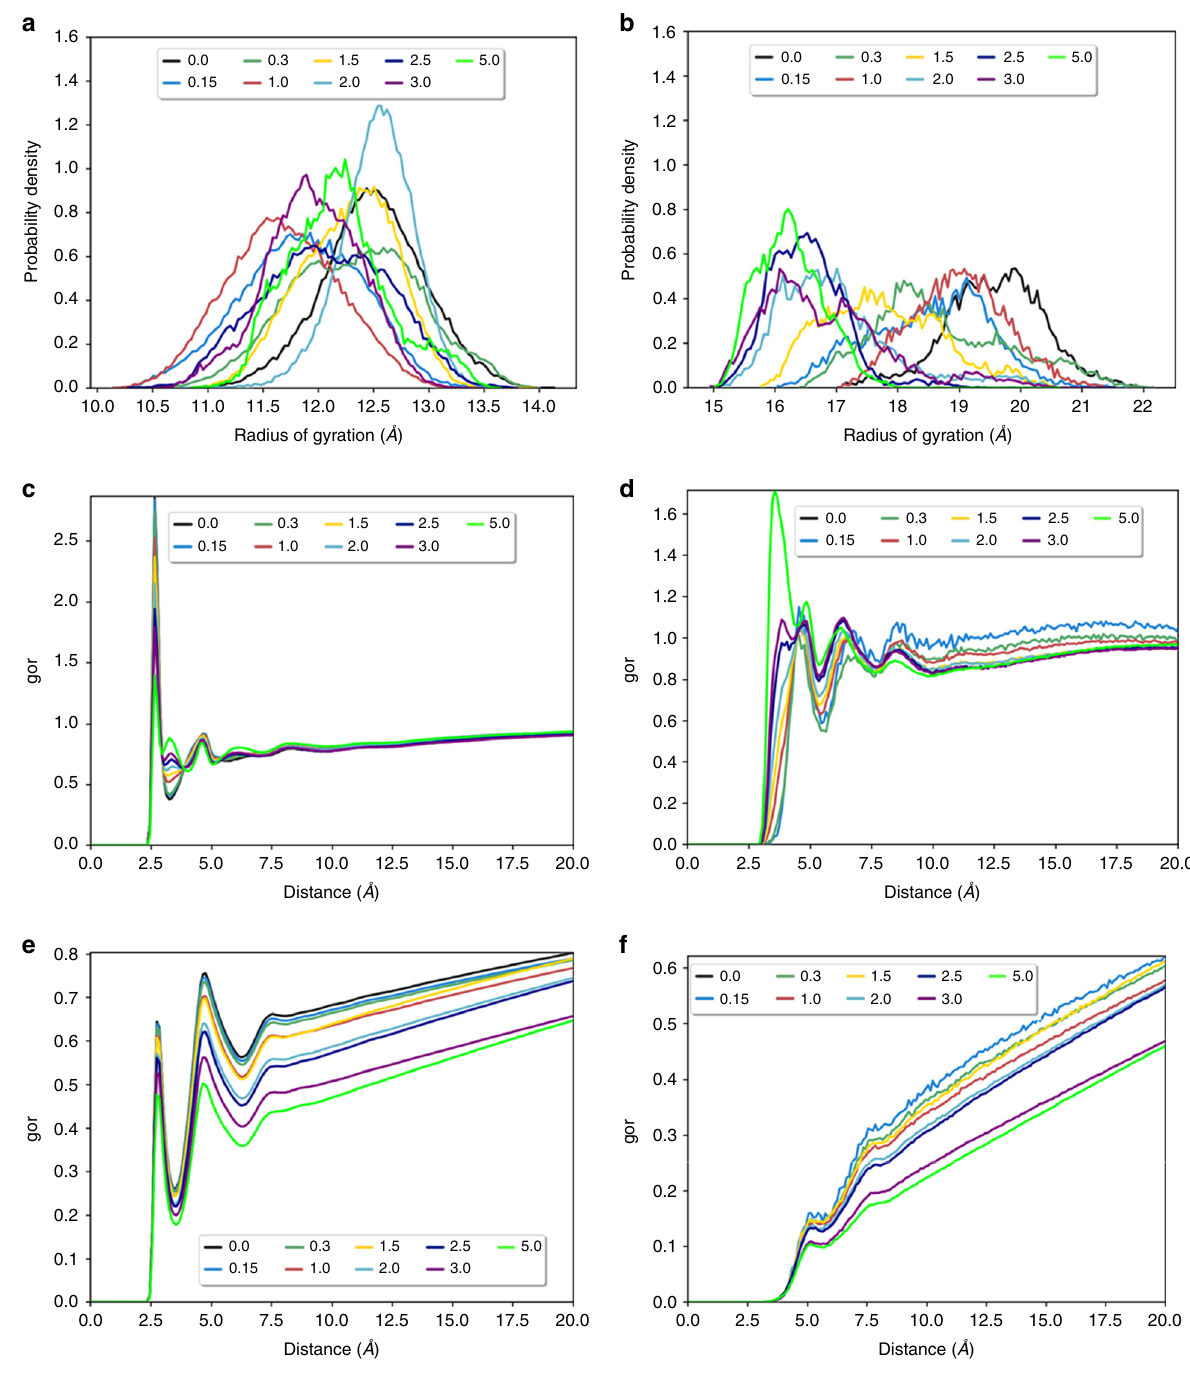
Fig. 4 Conjugate size and hydration state from MD simulations. Radius of gyration of a free pCBMA and b free pOEGMA in increasing NaCl concentration. Radial distribution functions (RDF) for Lyz(5 + )pCBMA DP 18 between c water molecules and O − atoms of pCBMA and d Cl − ions and O − atoms of pCBMA in increasing NaCl concentrations. Hydration layer increases as NaCl concentration increases and both water molecules and Cl − ions become more ordered. Radial distribution function analyses for Lyz(5 + )pOEGMA DP 25 between e water molecules and PEG in the pOEGMA monomer side-chain and f Cl − ions and PEG in the pOEGMA monomer side-chain in increasing NaCl. Hydration decreases with increasing salt for Lyz(5 +